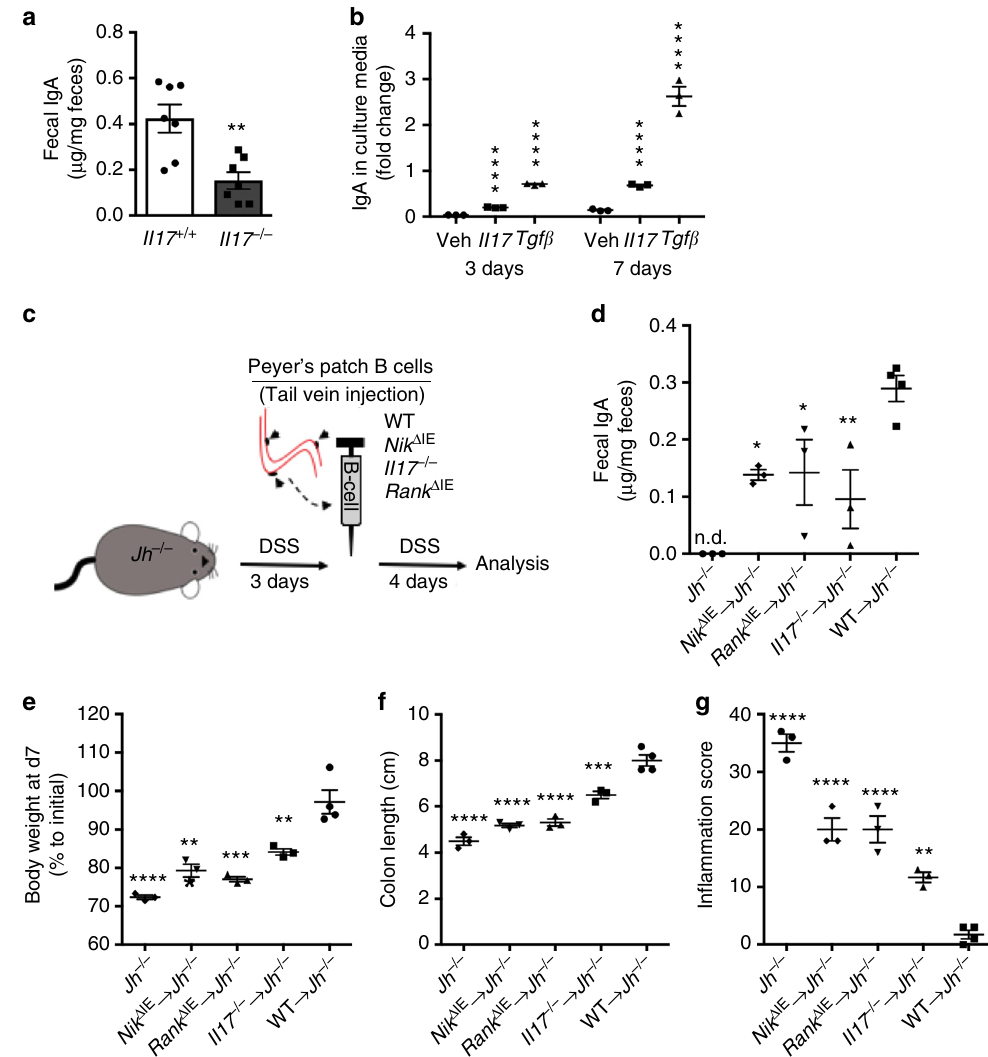
Fig. 5 IL-17-mediated IgA production is protective in colitis. a Fecal IgA in 6-week-old Il17 − / − mice. b IgA production from PP B-cells at day 3 or 7 following induction with IL17 or Tgf β . c Schematic representation of transplant performed in Jh − / − mice with Peyer ’ s patches B-cells isolated from WT, Nik Δ IE , Rank Δ IE , or Il17 − / − mice. d – g Fecal IgA ( d ), body weight ( e ), colon length ( f ), and in fl ammation score ( g ) in 8-week-old Jh − / − chimeras that were treated with DSS for 7 days. Results are expressed as mean ± SEM. Signi fi cance determined using t -test for a , b and one-way ANOVA for d – g . * P < 0.05; ** P < 0.01; *** P < 0.001; **** P < 0.0001 vs. Il17 + / + or Jh − / − WT